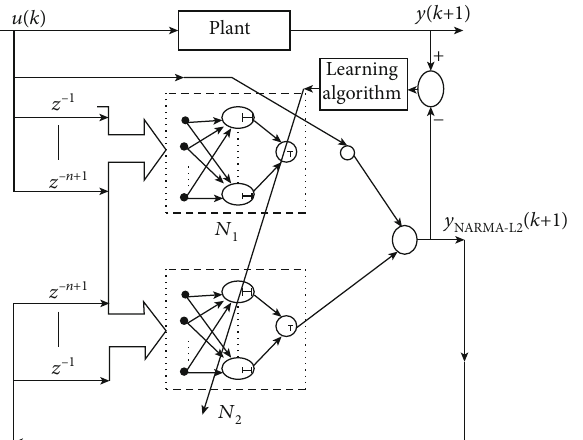
Figure 3: Nonlinear autoregressive and moving